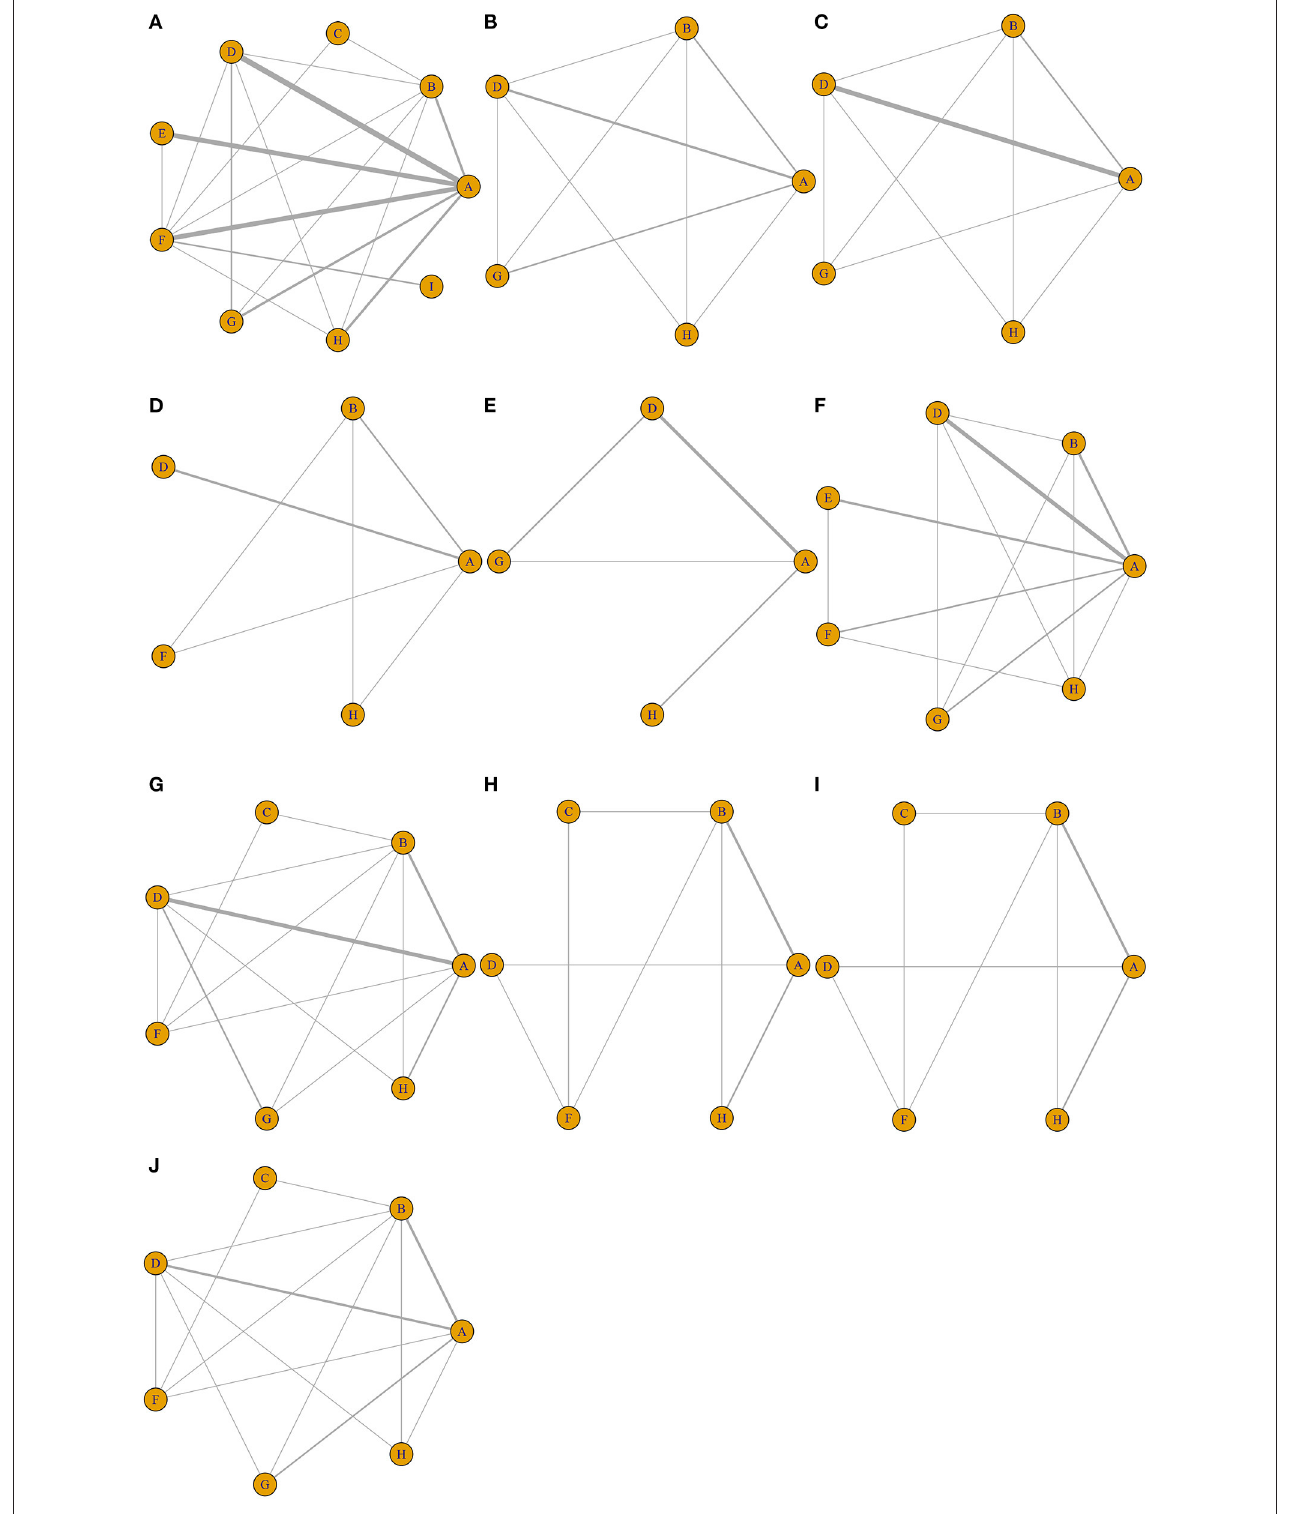
FIGURE 2 | Network structure diagrams. As shown in the figure, the thickness of the lines is proportional to the number of comparisons, and the diameter of the circles is proportional to the number of treatments included in the meta-analysis. (A) All-cause rebleeding. Rebleeding at (B) 1 year, (C) 2 years, and (D) 3 years. (E) Treatment failure. (F) Bleeding-related mortality. OS at (G) 1 year, (H) 2 years, and (I) 3 years. (J) Hepatic encephalopathy.